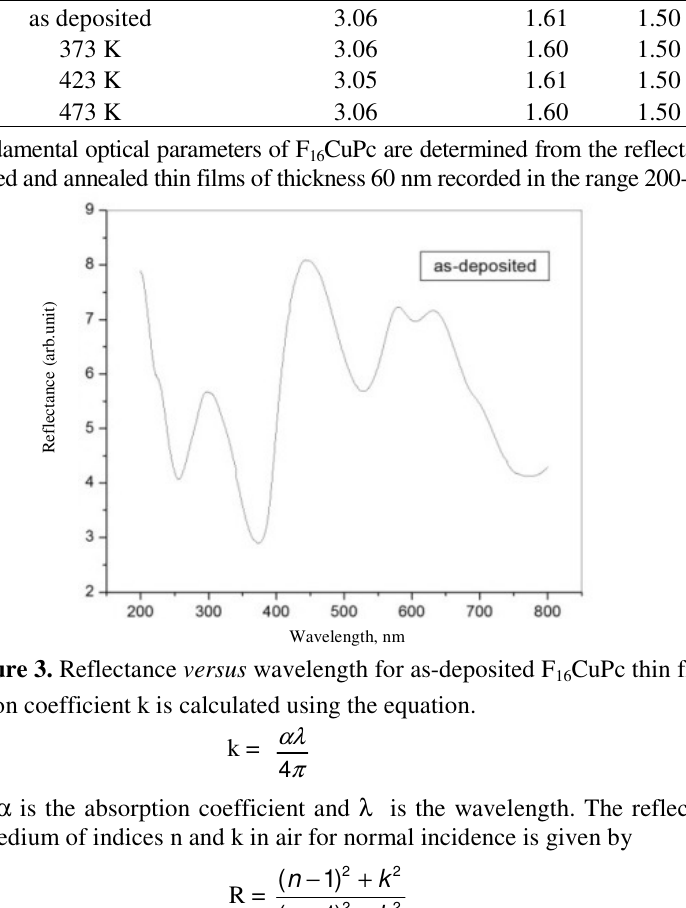
CuPc thin film 16